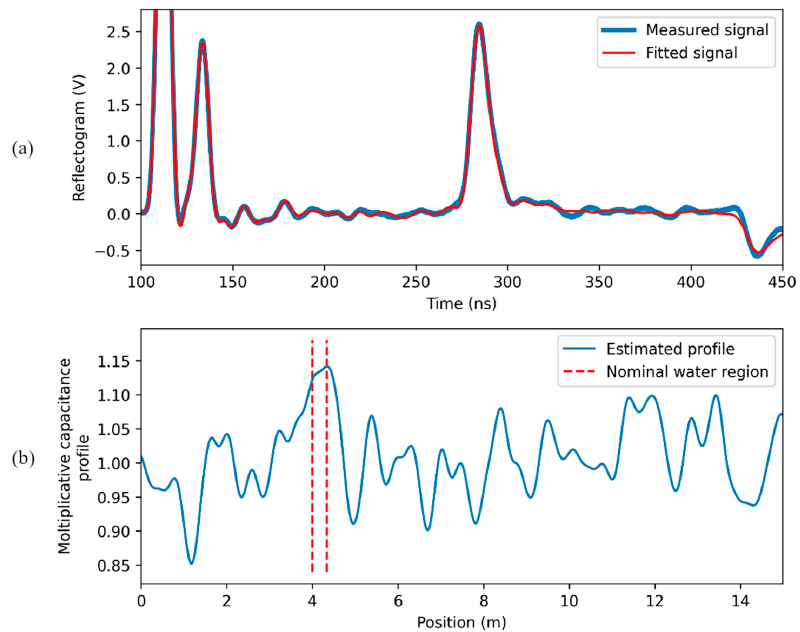
Figure 8. Results of the “direct water leak estimation” in the case of a weak reflected pulse: ( a ) meas- ured and fitting signal; ( b ) estimated capacitance profile. ( a ) measured and fitting signal; ( b ) estimated capacitance